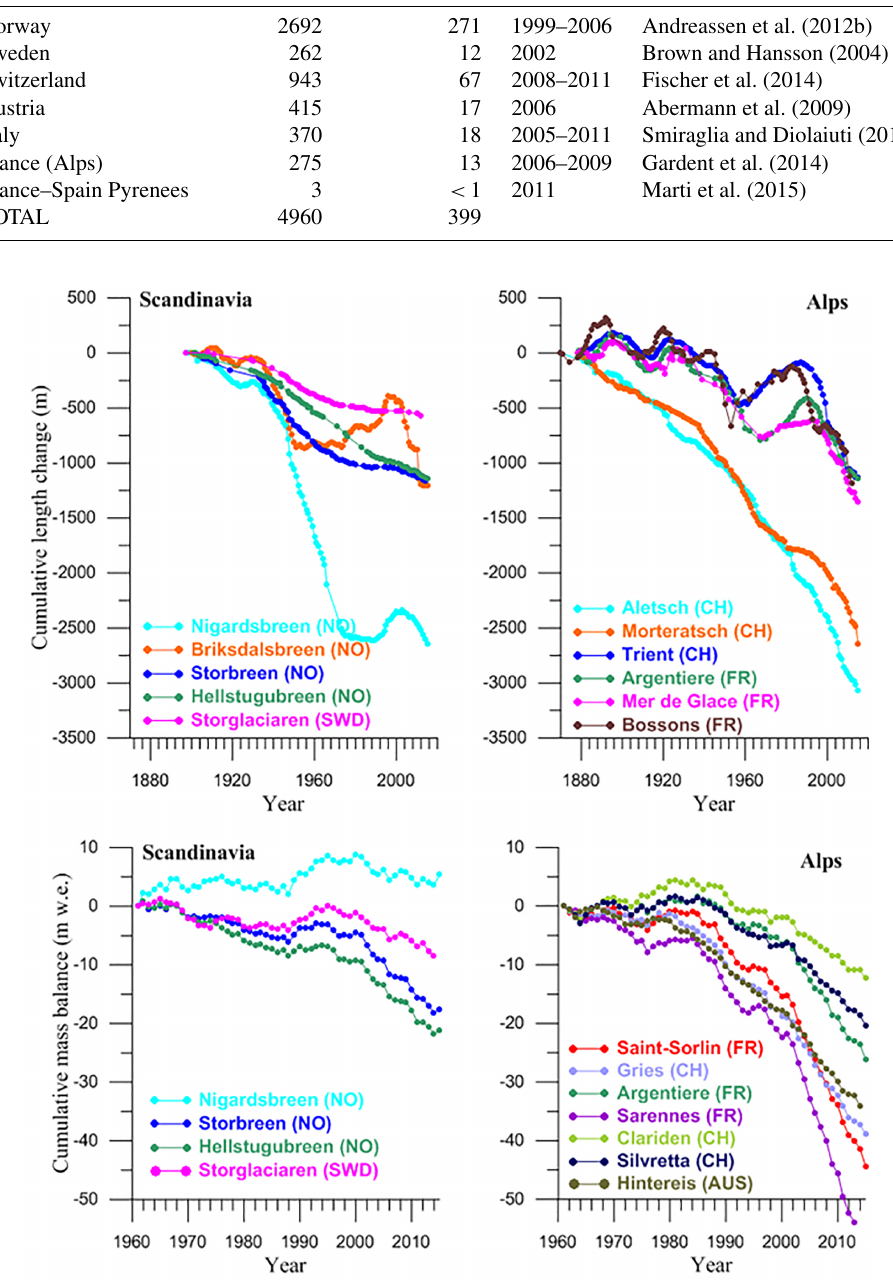
Figure 2. Length and surface mass balance changes documented with in situ measurements for glaciers in Scandinavia and in the European Alps. Sources: WGMS (2015) and earlier issues with updates (Andreassen et al.,